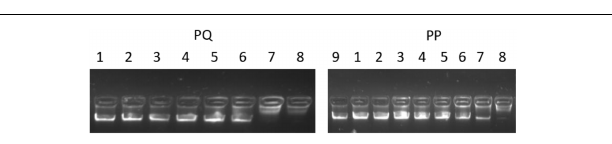
FIGURE 11 | The total genomic DNA binding assay. Various concentrations of peptides were incubated with 600 ng DNA for 1 h at room temperature; Lane 1: genomic DNA alone; lane 2: with 2 µ M peptide; lane 3: with 4 µ M peptide; lane 4: with 8 µ M peptide; lane 5: with 16 µ M peptide; lane 6: with 32 µ M peptide; lane 7: with 64 µ M peptide; lane 8: with 128 µ M peptide; lane 9: with 256 µ M